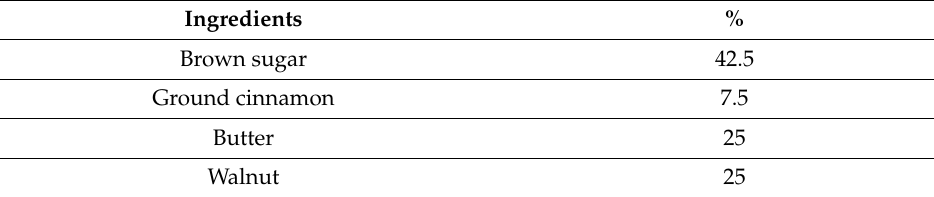
Table 2. Filling ingredients of cinnamon rolls.